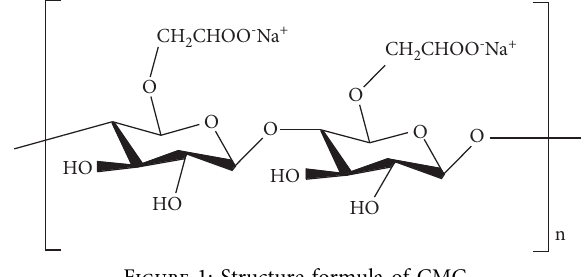
Figure 1: Structure formula of